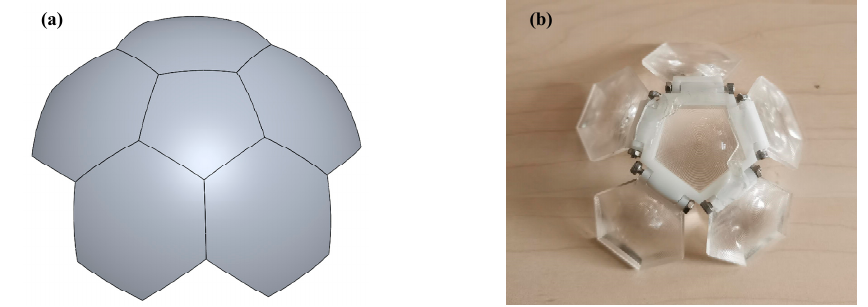
Figure 3. ( a ) Schematic diagram of a 6-lens array; ( b ) Assembled 6-lens array.